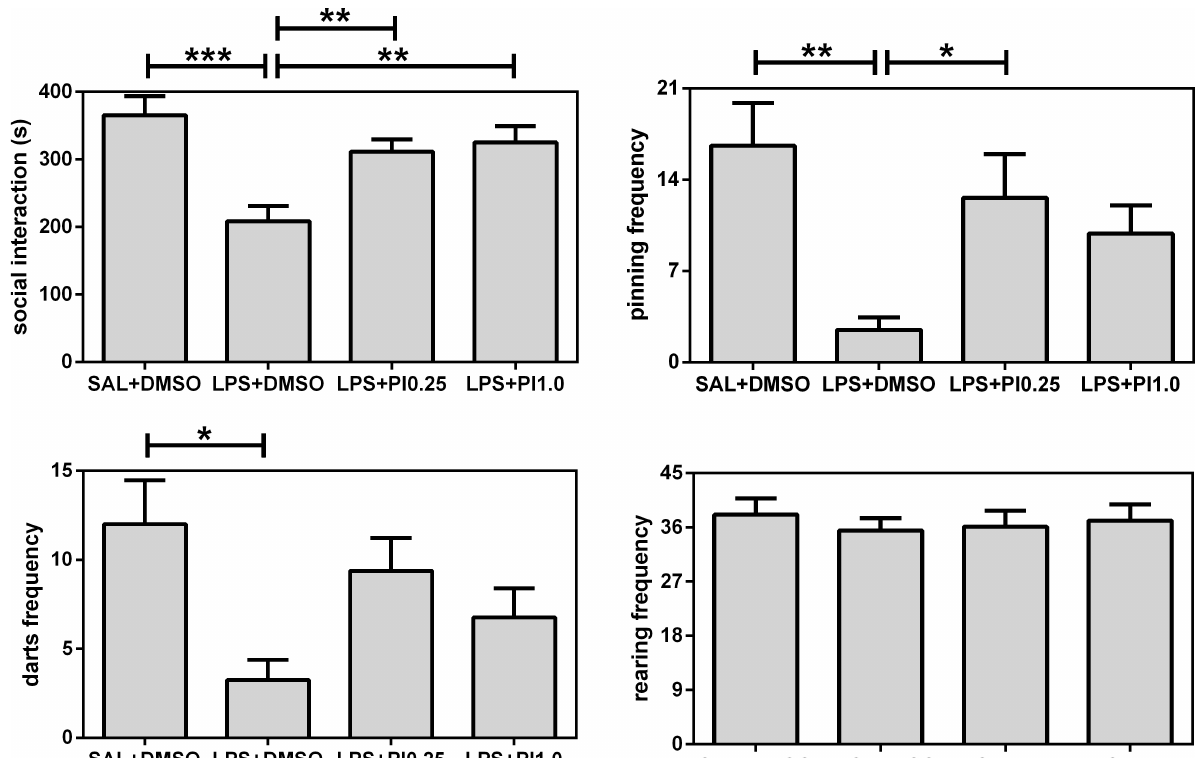
Fig 1. Play behaviors. The effects of prenatal LPS (100 μ g/kg at gestational day 9.5) and postnatal pioglitazone (0.25 and 1.0 mg/kg/day between postnatal days 21 and 29) exposures on play behaviors in juvenile male rat offspring. SAL+DMSO, prenatal saline injection and postnatal daily DMSO injection; LPS+DMSO, prenatal LPS injection and postnatal daily DMSO injection; LPS+PI0.25, prenatal LPS injection and postnatal pioglitazone 0.25 mg/kg/day; LPS+PI1.0, prenatal LPS injection and postnatal pioglitazone 1.0 mg/kg/day ( n = 8 rats/group). (cid:3) p < 0.05, (cid:3)(cid:3) p < 0.01, and (cid:3)(cid:3)(cid:3) p < 0.0001 (one-way ANOVA followed by the Newman-Keuls test). The data are expressed as the mean ± the SEM.